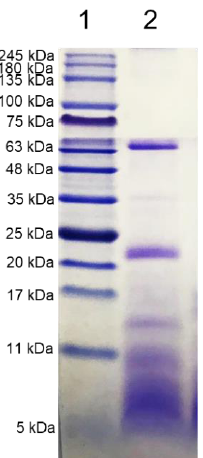
Figure 2. Tricine-SDS-PAGE results: (line 1) molecular-weight marker and (line 2) rice protein hydrolysate.